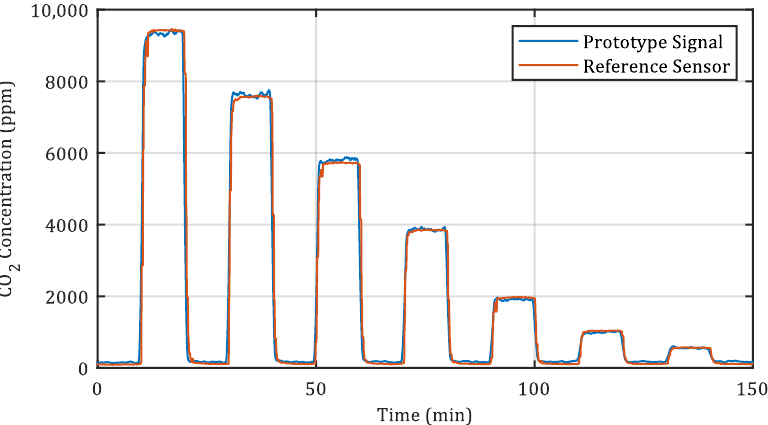
Figure 7. Calibrated sensor response absorption distance of d = 15.5mm showing 10min steps with decreasing CO 2 concentration together with the output of an NDIR reference sensor (12-times moving mean applied).